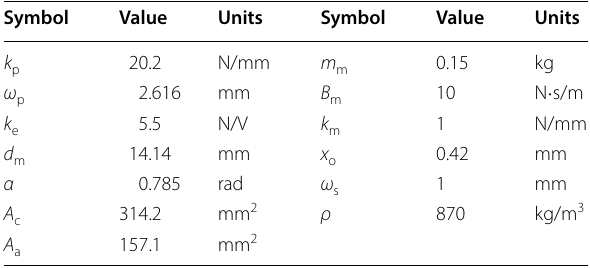
Table 2 Parameters of the tested